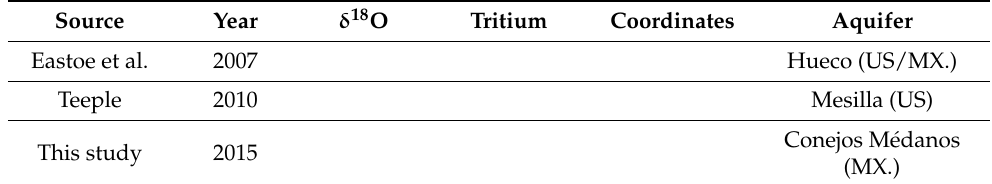
Table 3. Data collected from different authors used in this